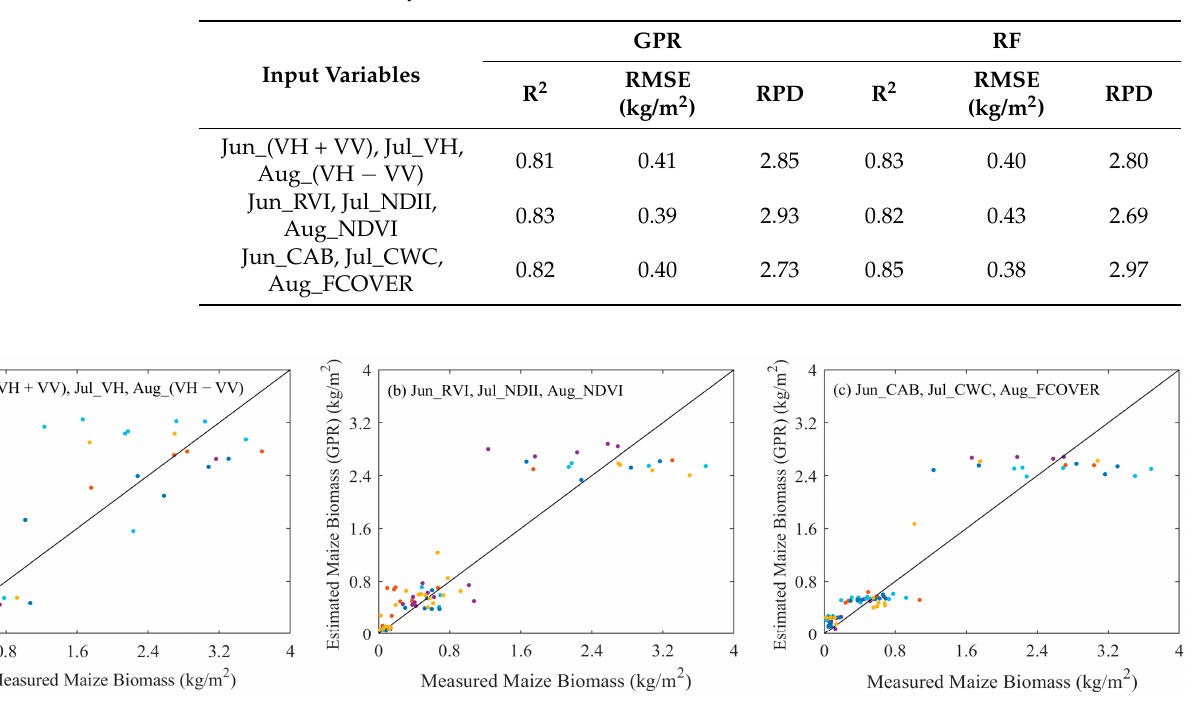
Figure 7. Measured vs. estimated biomass by GPR with combined predictors. The different colors indicated the 5-fold